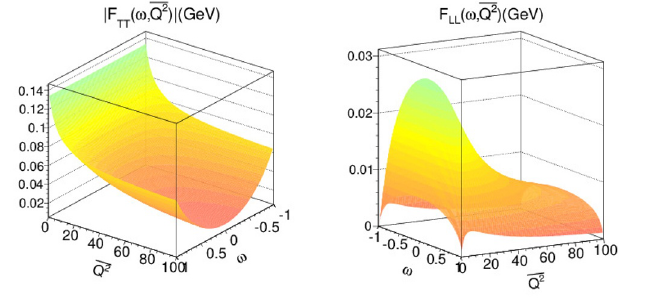
Figure 5 . j F TT j (left) and F LL (right) form factors for the Buchm(cid:127)uller-Tye potential as a function of ! and Q 2 for (cid:31) c 0